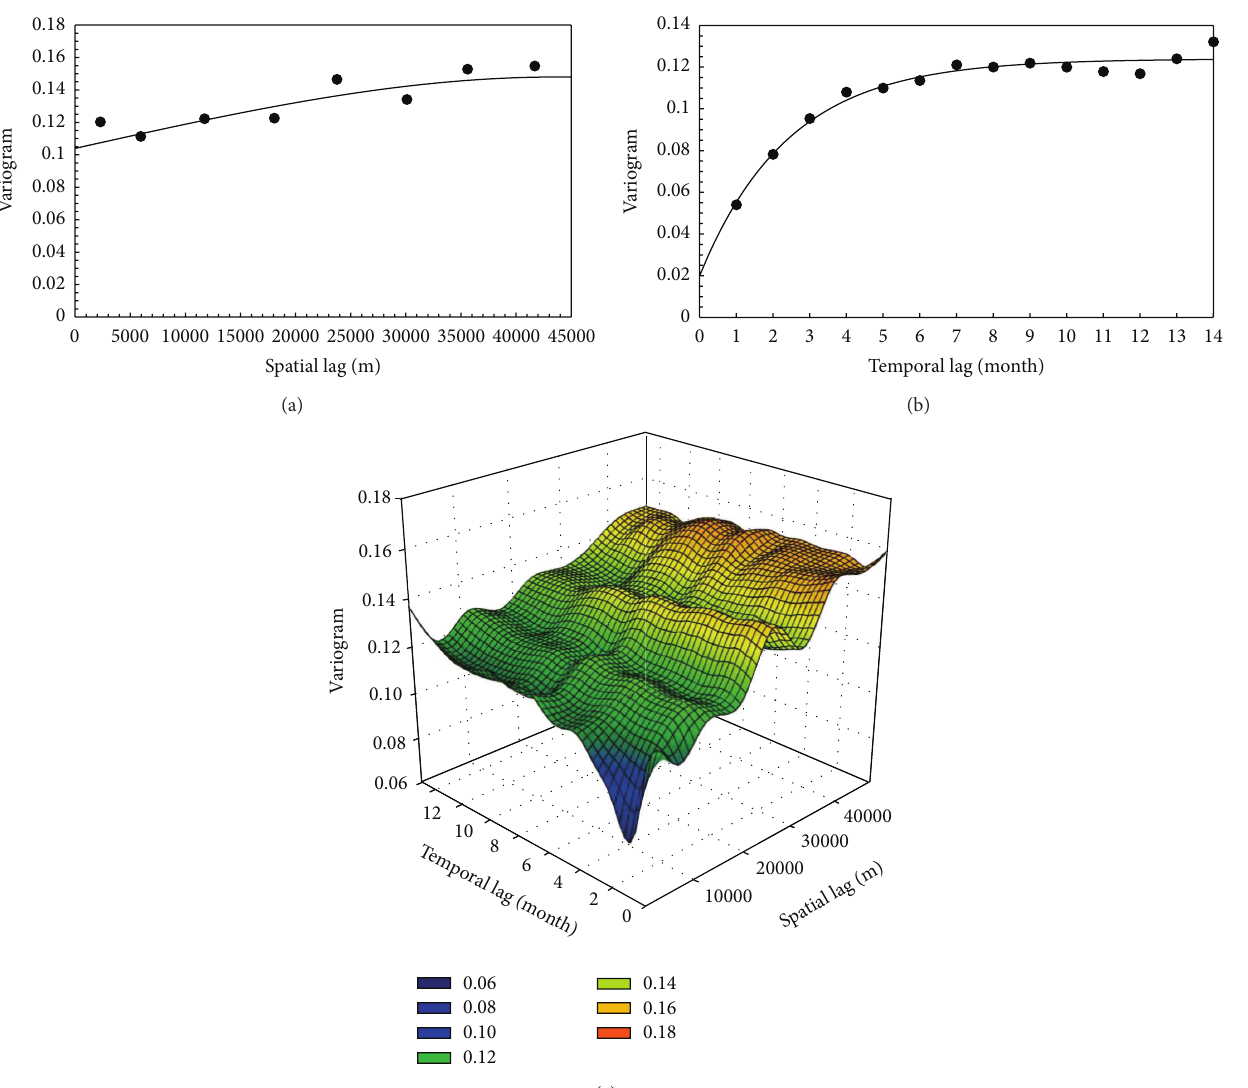
Figure 5: Marginal experimental variograms with the fitted model: (a) spatial variogram and (b) temporal variogram. Experimental spatiotemporal variogram surface of the residuals is shown in